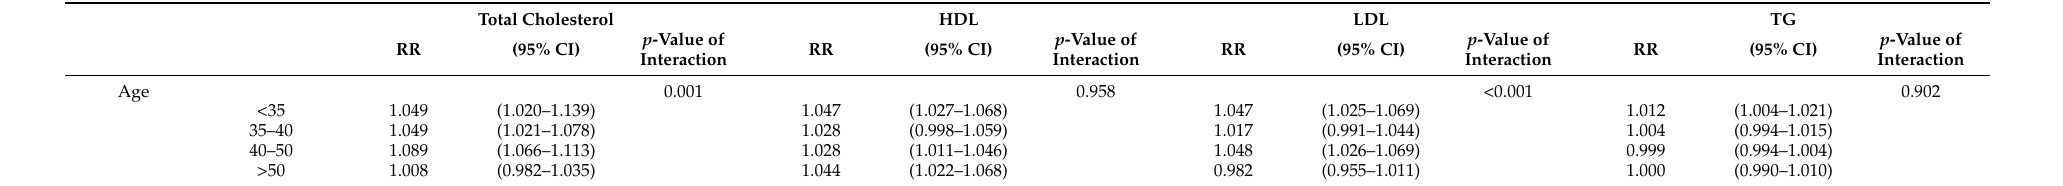
Table 4. Relative Risk of patients with increased total cholesterol, LDL, TG and a decrease in HDL levels, divided by categories of age, sex, BMI, glycemic status and hypertension status. Patients were deemed to have worsened when they changed to an upper category in the corresponding risk factor: BMI (normal, overweight, obesity); glycemic status (normal, prediabetes, diabetes); blood pressure status (normal, pre-AHT, AHT1, AHT2); waist (normal, high); fat mass (normal, high, very high); total cholesterol (normal, high); LDL (normal, high); HDL (normal, low); and TG (normal,